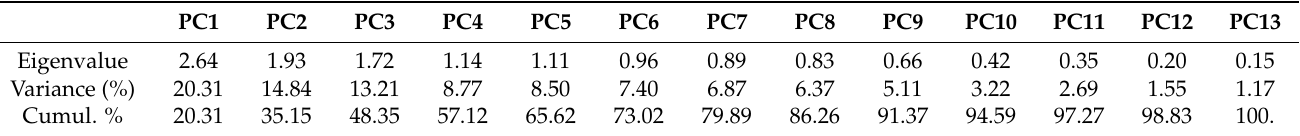
Figure 5. Distribution of parameters on ( a ) PC1 and PC2 axes, ( b ) PC1 and PC3 axes, ( c ) PC1 and PC4 axes, ( d ) PC1 and PC5 axes, and ( e ) PC1 and PC6 axes. Table 2. Eigenvalues and percentage of explained variance by the first principal components. Only PC1 to PC6 are taken into account in this